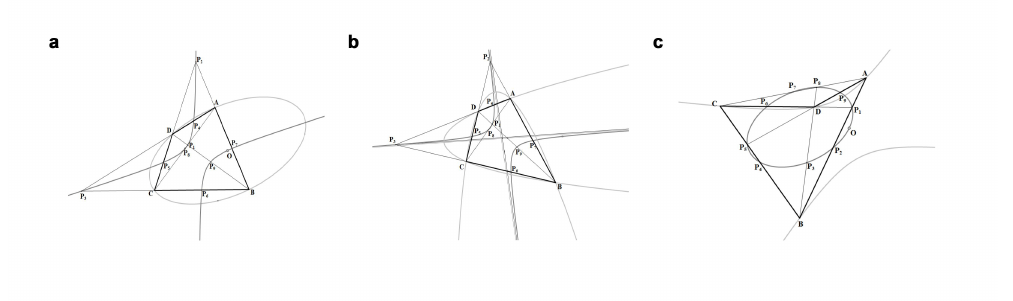
Figure 4: The locus of the center of circumscribed conics. (a) The locus of the center of circumscribed conics of a convex quadri- lateral is its nine-point curve, which is a hyperbola. (b) The axes of symmetry of a general convex quadrilateral’s two circum- scribed parabolas are parallel to the asymptotic lines of its nine-point curve, respectively. (c) The center O of the circumscribed conics of a concave quadrilateral is on its nine-point curve, which is an